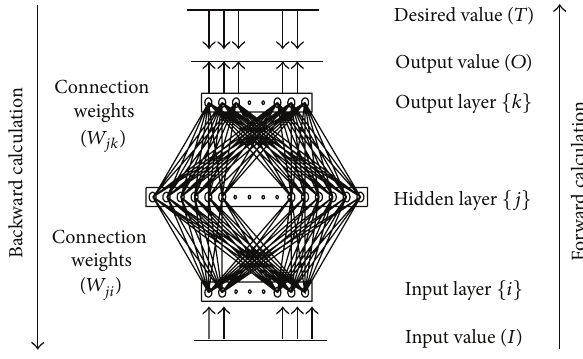
Figure 3: Backpropagation of